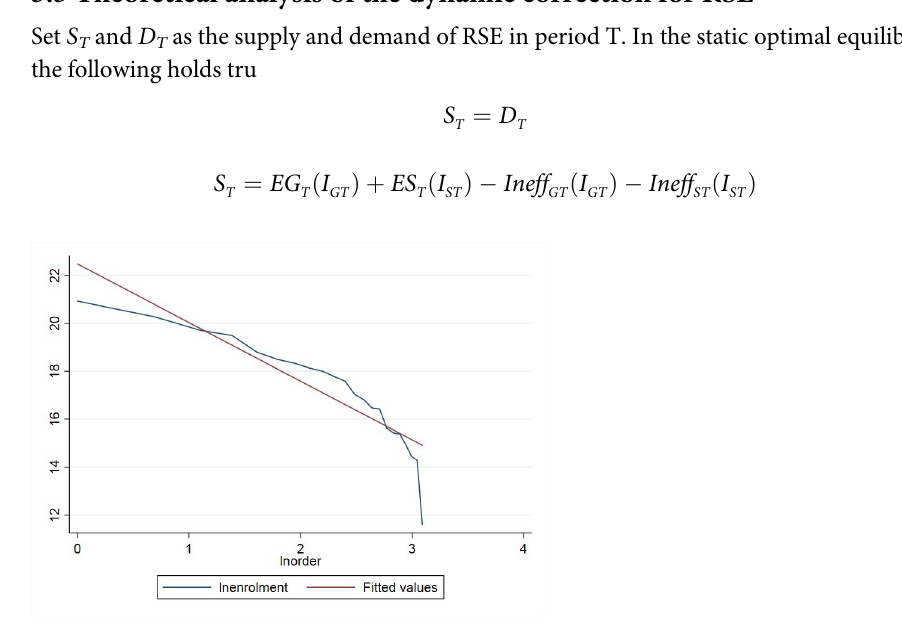
Fig 6. The double logarithmic distribution curve of enrolled student numbers for different education categories in China from 2003–2014.